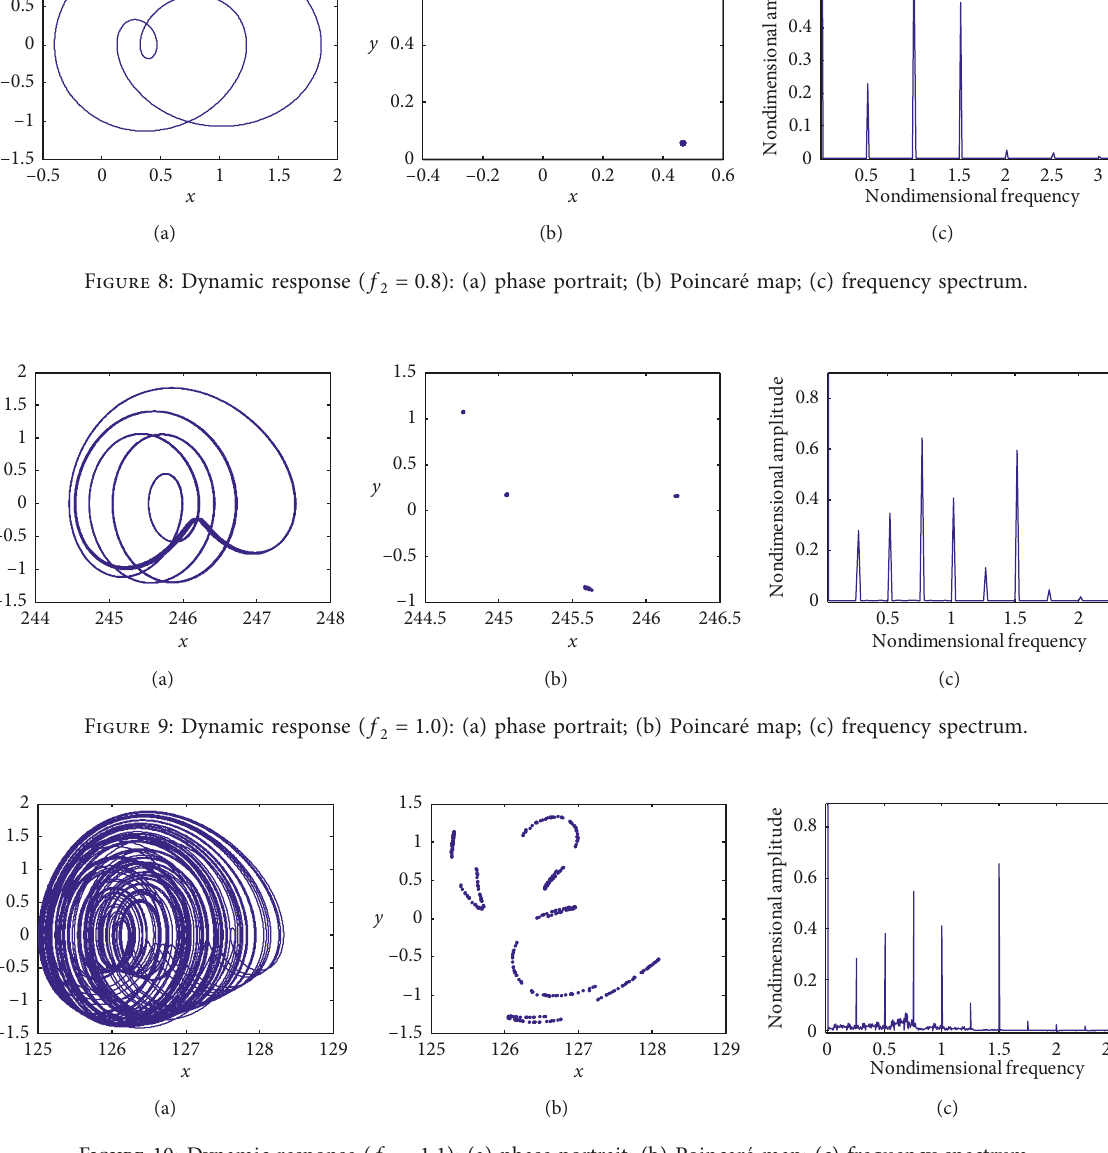
Figure 10: Dynamic response ( f � 1 . 1): (a) phase portrait; (b) Poincar´e map; (c) frequency spectrum. 2